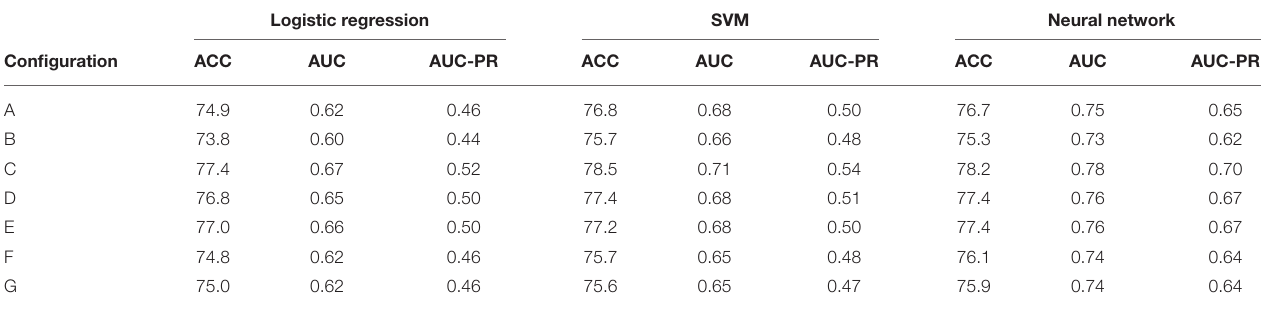
TABLE 4 | Model performance on different window configurations for the observation period. Logistic regression SVM Neural network Configuration ACC AUC AUC-PR ACC AUC AUC-PR ACC